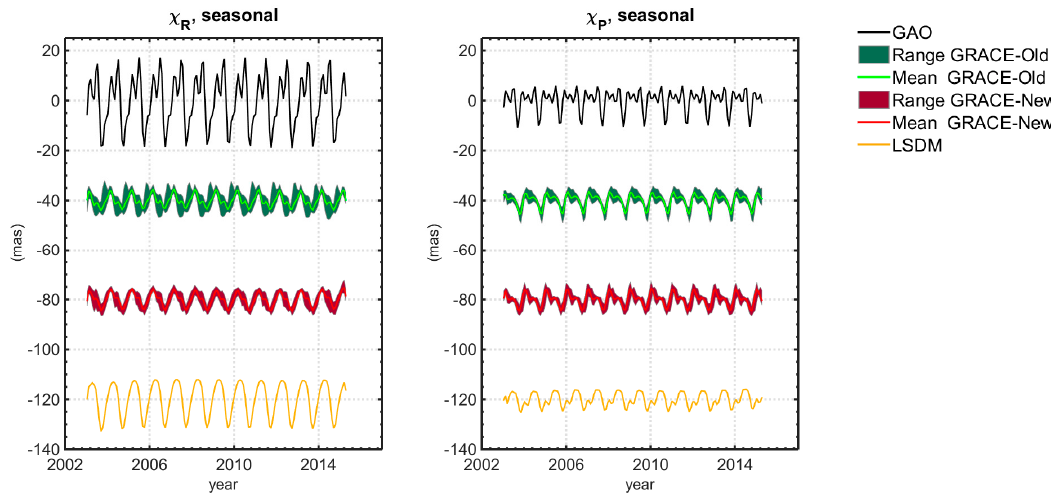
Figure 2. Comparison of mean value with ranges between minimum and maximum for χ R and χ P of seasonal variation in HAM for the old and new GRACE solutions. Time series of GAO and HAM from the LSDM are provided for comparison. The units are milliseconds of arc (mas). For better visibility, a bias was added to various HAM in order to shift them relative to each other.